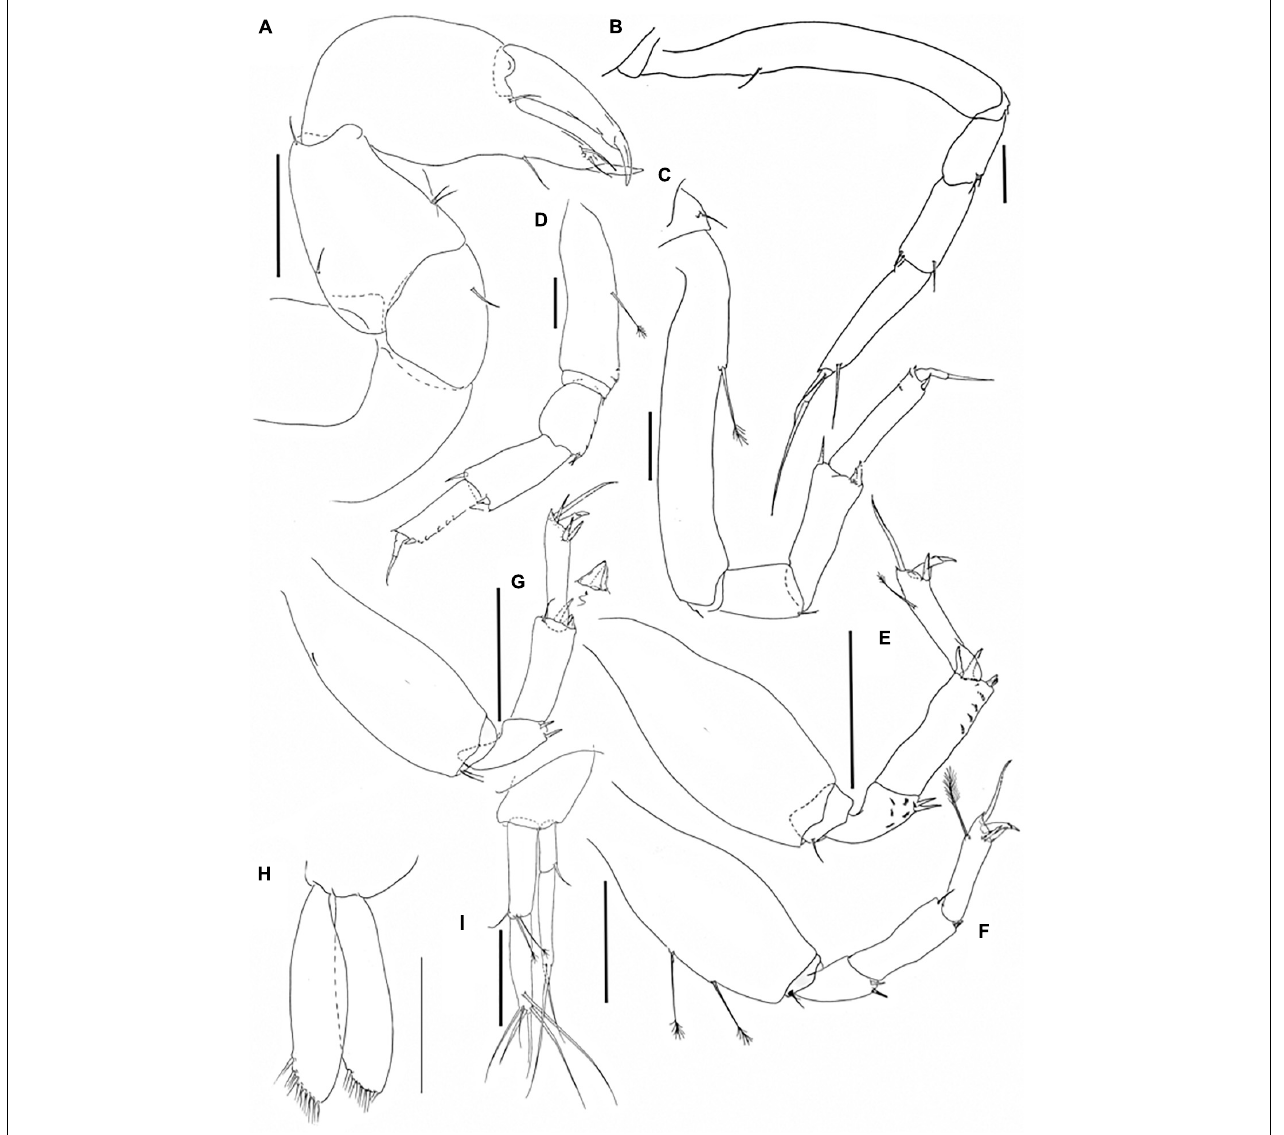
FIGURE 11 | Pseudotanais shirazi sp. nov.; neuter (J74952), (A) , cheliped; (B) , pereopod-1; (C) , pereopod-2, (D) , pereopod-3; (E) , pereopod-4; (F) , pereopod-5; (G) , pereopod-6; (H) , pleopod; (I) , uropod. Scale lines = 0.1